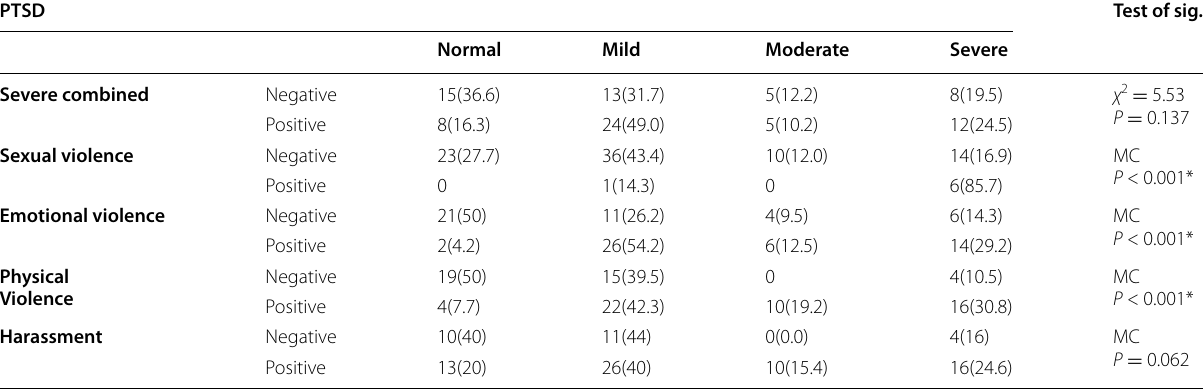
χ 2 chi-square test, MC Monte Carlo test =